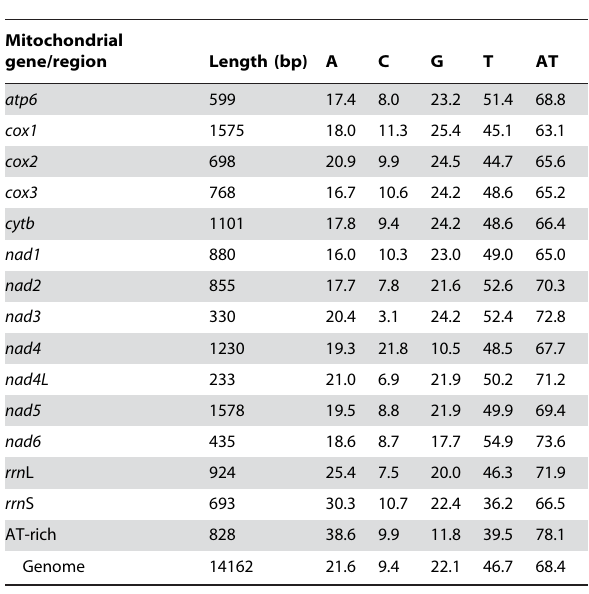
Table 1. Lengths and A + T contents (%) of the sequences of the 12 protein-coding genes, the large and small ribosomal RNA genes, the AT-rich region and of the entire mitochondrial genome of Toxocara canis